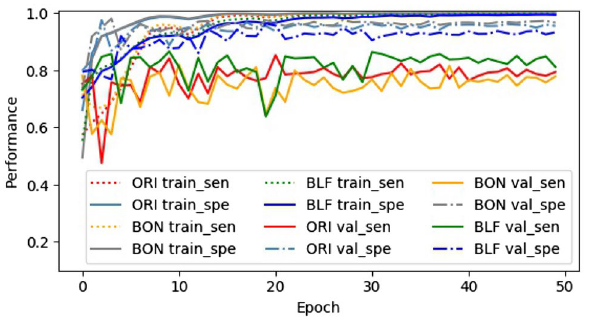
Figure 5. Sensitivity and specificity of ORI, BON, and BLF models during training and on the validation